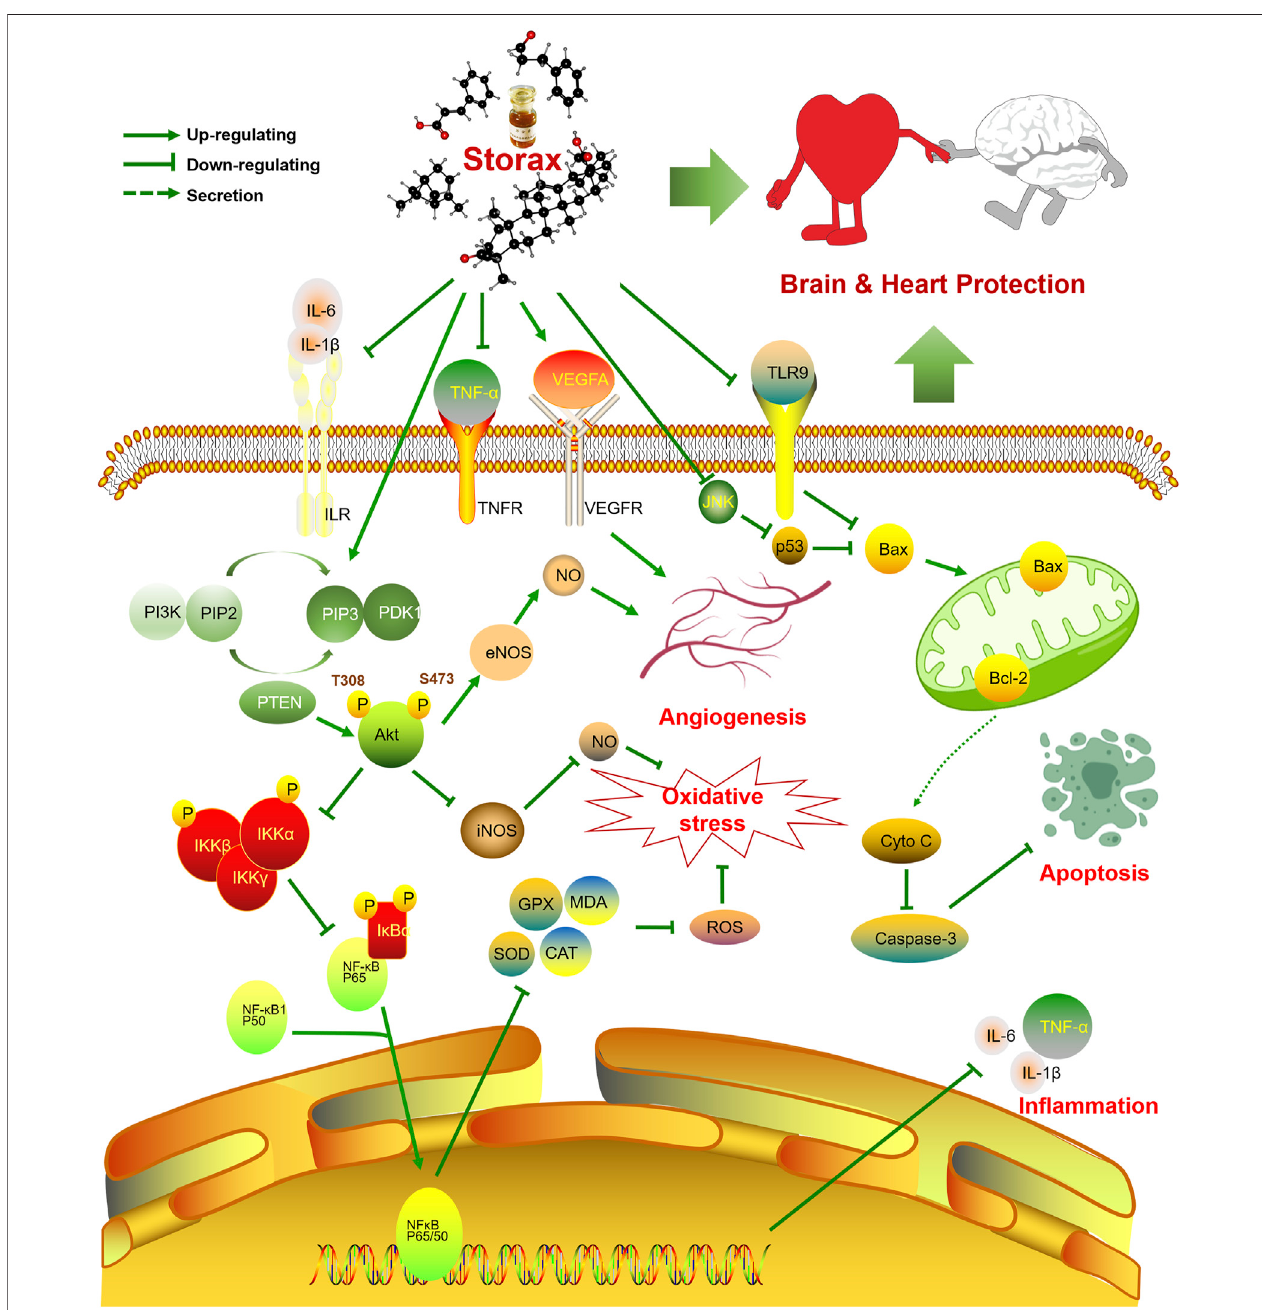
FIGURE 7 | Schematic diagram of the regulatory mechanism of the brain-heart protective effect of storax. Storax can activate PI3K/Akt signaling pathway and inhibit NF- κ B signaling pathway, which in turn can play a role in regulating NO production, anti-in fl ammatory, anti-oxidative stress and pro-angiogenic pharmacological effects, as well as anti-apoptosis by elevating Bcl-2 and inhibiting the expression of Caspase-3 and Bax, thus playing a co-protective role in the brain and heart.